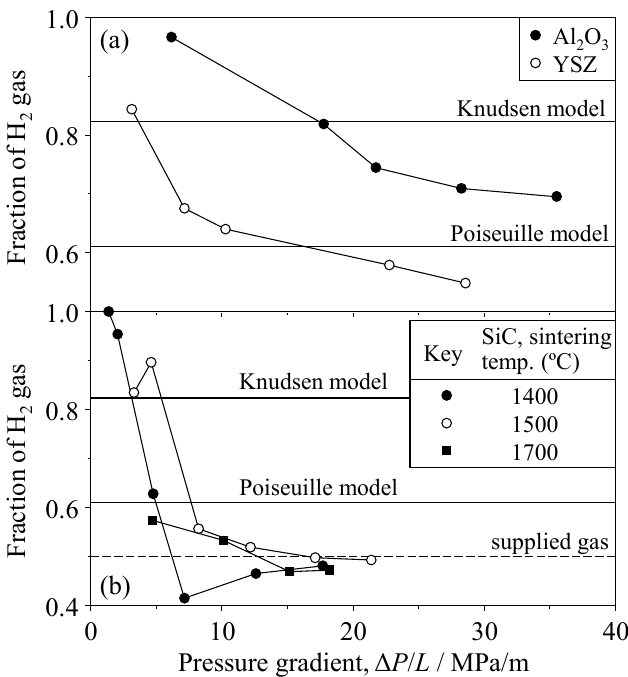
Figure 13. Fraction of H 2 gas for the 50 vol % H 2 –50 vol % CO 2 mixed gas through ( a ) Al 2 O 3 and YSZ and ( b ) SiC.